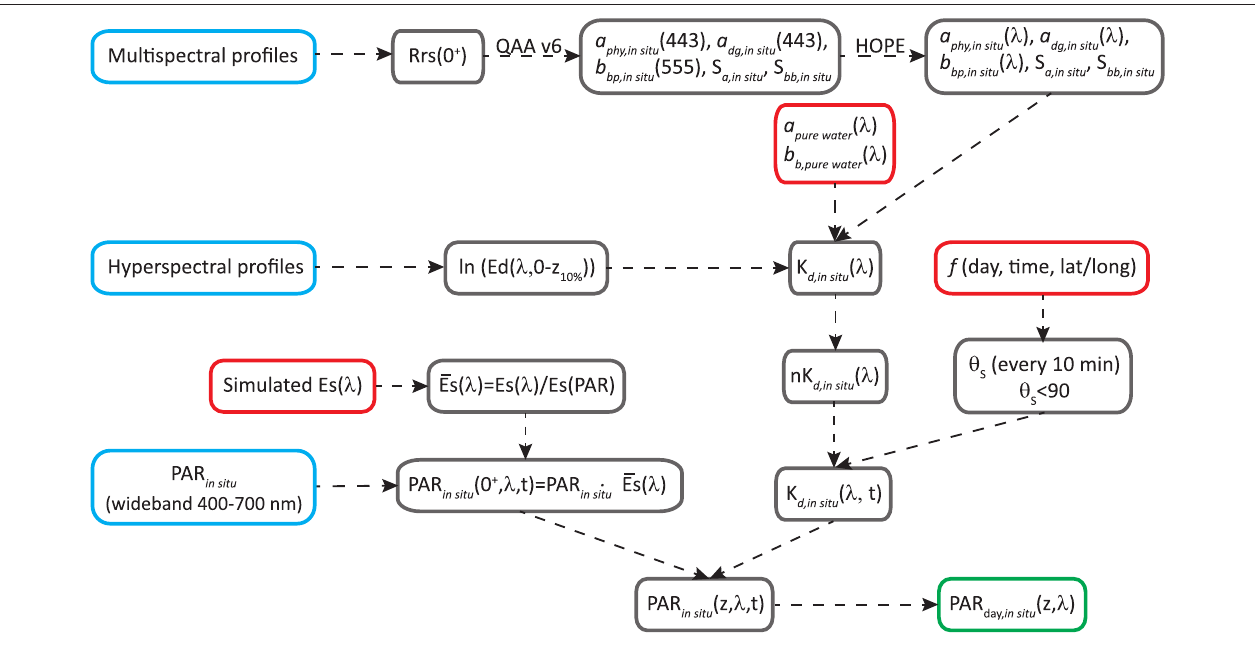
FIGURE 2 | Flow-chart to obtain daily PAR (PAR day, in situ ) from in situ